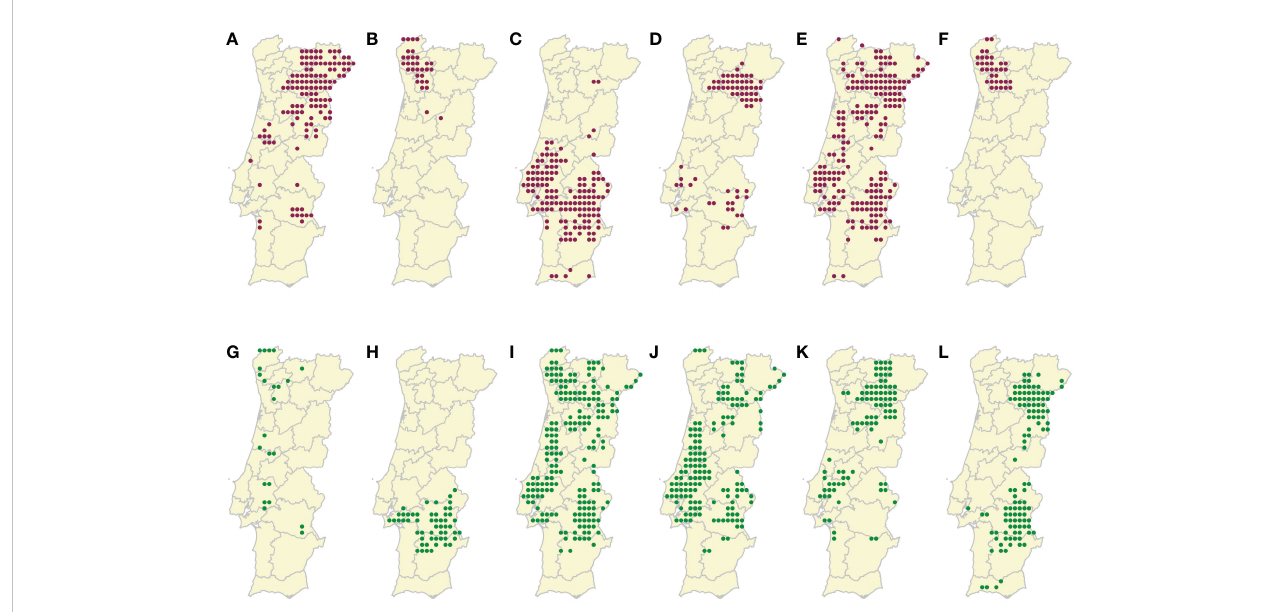
FIGURE 2 Sampled locations of the (A) Alvarinho (number of locations, N=23), (B) Antão-Vaz (N=54), (C) Arinto (N=198), (D) Fernão-Pires (N=153), (E) Malvasia-Fina (N=92), (F) S ı ́ ria (N=113), (G) Bastardo (N=123), (H) Borrac ̧ al (N=31), (I) Castelão (N=137), (J) Touriga-Franca (N=67), (K) Touriga-Nacional (N=202), and (L) Vinhão (N=33) grapevine varieties in mainland Portugal. Green dots represent white varieties and red dots represent red varieties. Polygons represent Portuguese NUTS 3 administrative units.